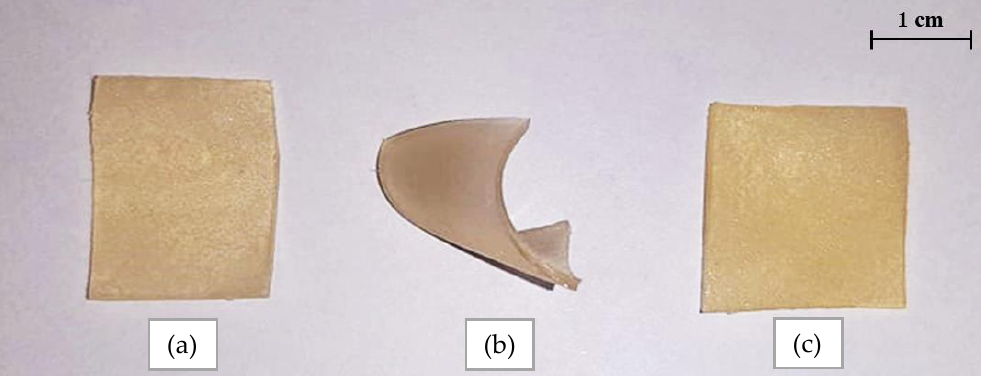
Figure 2. Images of hydrogels: unmodified sample ( a ), sample modified with cold starch suspension ( b ) and hot starch solution ( c ).